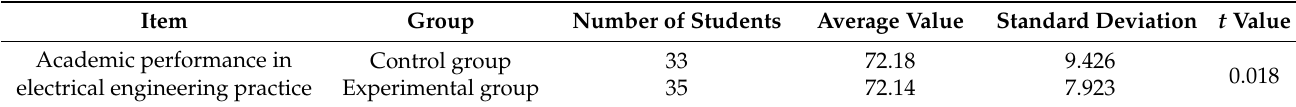
Table 3. Recapitulation sheet of students’ prior knowledge scores.